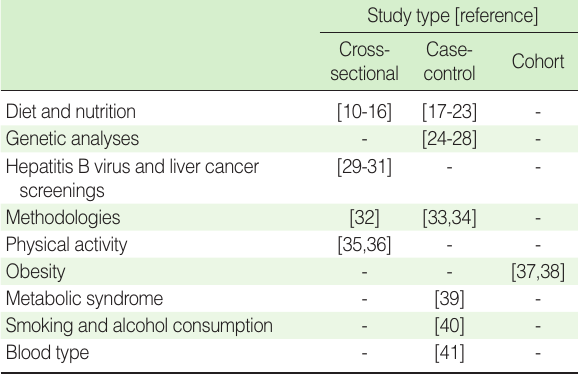
Table 4. List of published papers using data from the Cancer Scree- nee Cohort Study